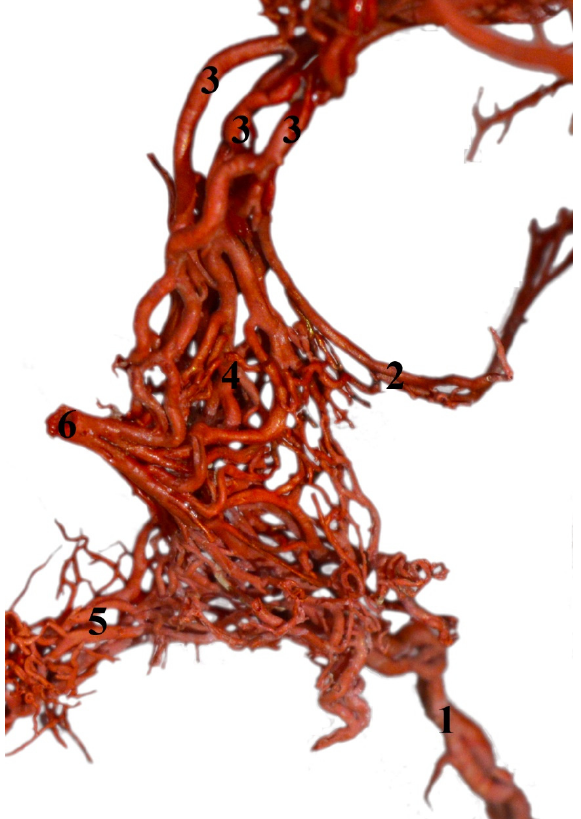
Figure 9. Rostral epidural rete mirabile in the common hippopotamus ( Hippopotamus amphibius ). A dorsolateral view and corrosion cast. 1—branch to the rostral epidural rete mirabile; 2—caudal branch to the rostral epidural rete mirabile; 3—rostral branches to the rostral epidural rete mirabile; 4—rostral epidural rete mirabile; 5—connection between the right and left rete mirabile; 6—intra- cranial part of the internal carotid artery.